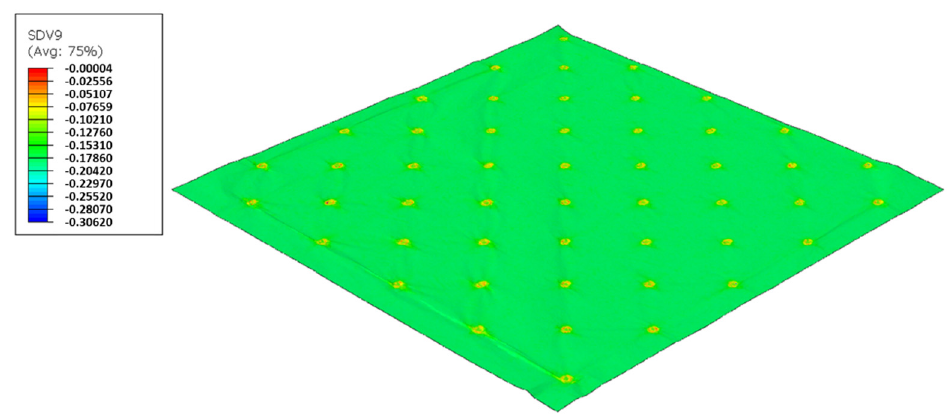
Figure 25. Micro die 75_48 Sh-A (CR PR/NR BG), Plastic field.